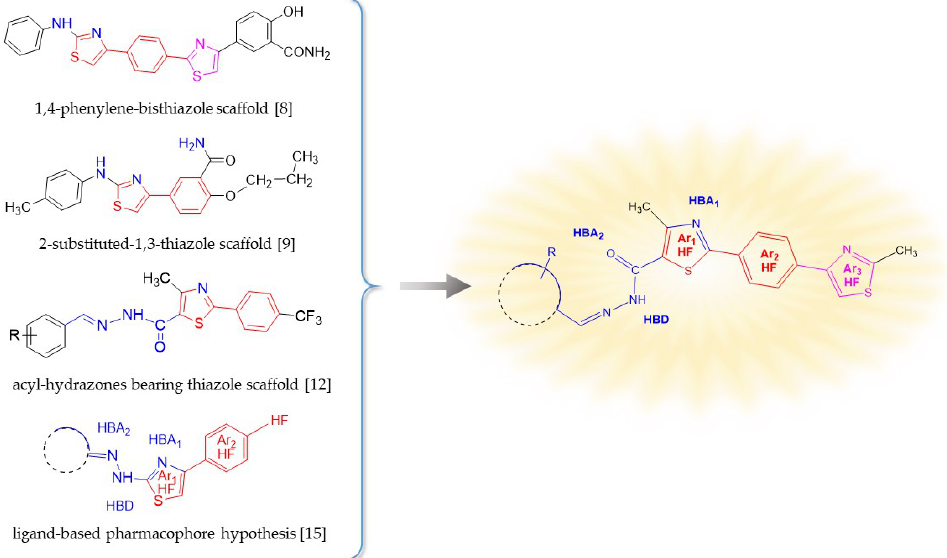
Figure 1. The design of the new 1,4-phenylene-bisthiazole acylhydrazone s.